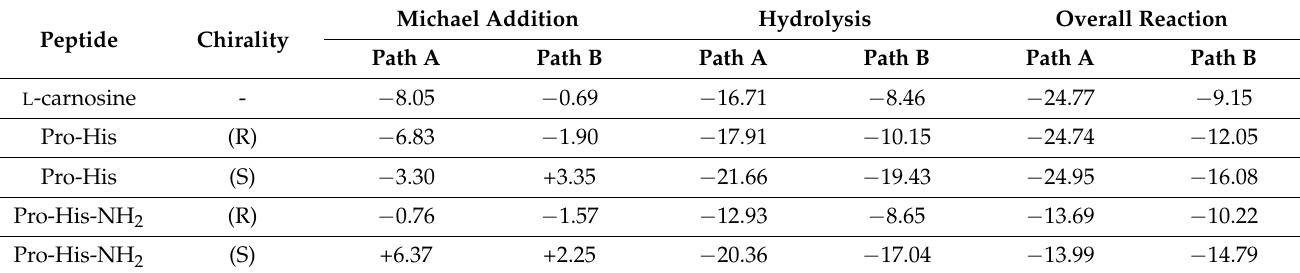
Table 3. Energy profiles for the quenching reactions for Pro-His and Pro-His-NH 2 . The stereoisomers generated by the two possible paths were investigated by DFT methods. Energy values for L -carnosine were also included for easy comparison (all values are expressed in